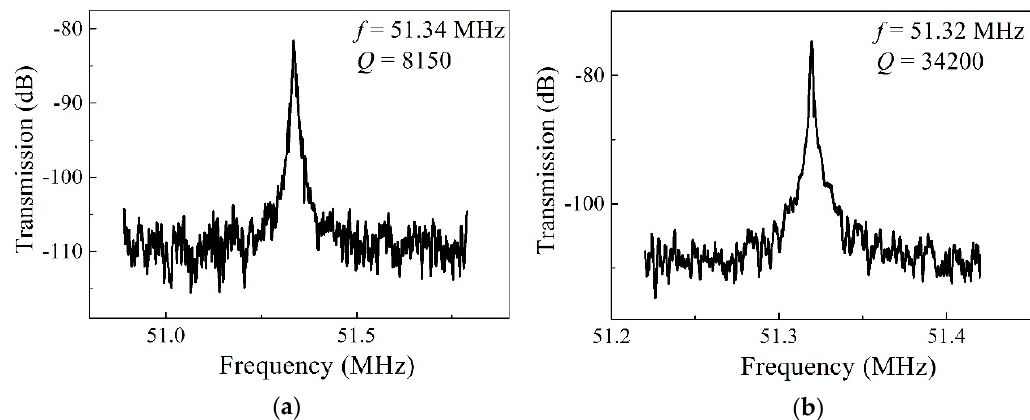
Figure 7. Transmission characteristic curves of the Lamé-mode resonator measured in air ( a ) and in vacuum (0.08 mbar) ( b ).